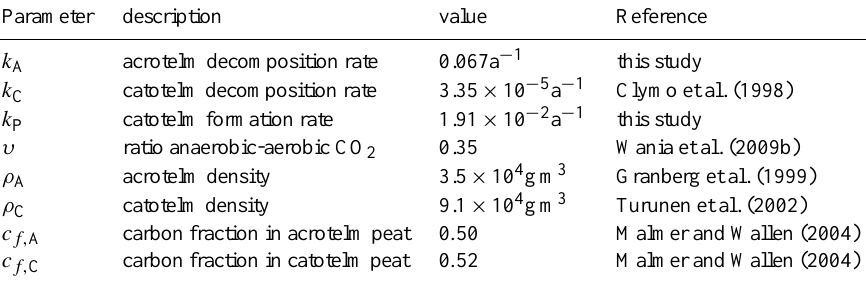
Table 1. Parameter values in peat